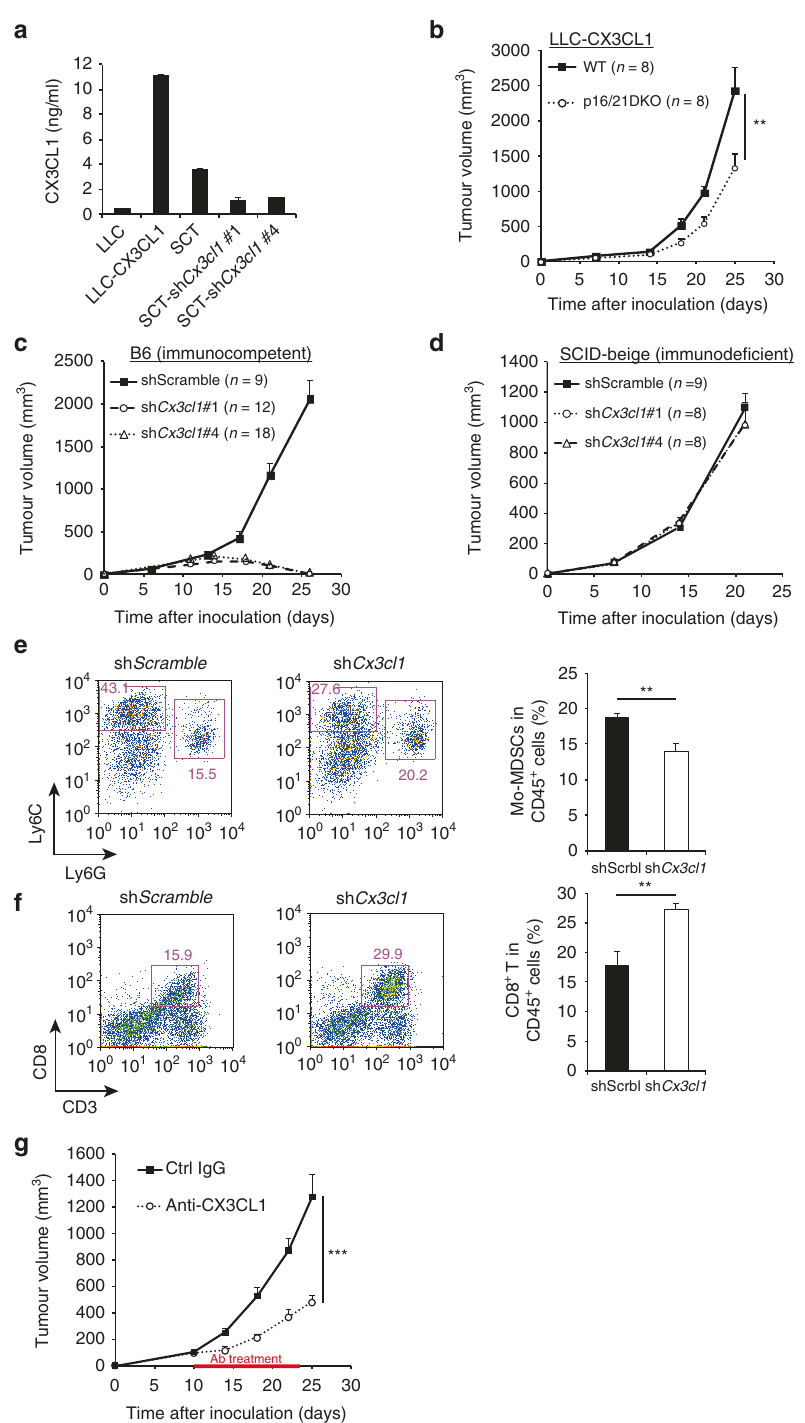
Fig. 4 CX3CL1 expression in tumour cells is associated with p16/p21-dependent tumour progression. a Amount of soluble CX3CL1 in the indicated conditioned medium, as measured by enzyme-linked immunosorbent assay. Data were normalised to cell number. SCT cells were retrovirally transduced to express shRNA targeting Cx3cl1 or a scrambled control shRNA. LLC-CX3CL1 indicates Cx3cl1 -transduced LLC cells. b The growth curve of CX3CL1- overexpressing LLC cells in WT and p16/p21-DKO mice. c , d Tumour size in WT ( c ) and SCID-beige ( d ) mice injected with SCT-shScramble, SCT- sh Cx3cl1 #1 and SCT-sh Cx3cl1 #4. e , f Representative fl ow cytometry plots of CD45 + CD11b + -gated ( e ) and CD45 + -gated ( f ) cells in tumours from WT mice 2 weeks after inoculation with Cx3cl1 -knockdown or control SCT cells. Cells were labelled with CD45, CD11b, Ly6C and Ly6G ( e ) and CD45 and CD8 ( f ) in WT mice intraperitoneally injected every other day with anti-CX3CL1 antibody (4 µ g per mouse) or isotype control rat IgG (4 µ g per mouse) from day 10 to 23; data are presented as the mean ± SEM. The statistical signi fi cance was determined by Student ’ s t- test; ** p < 0.01 and *** p < 0.001; NS not signi fi